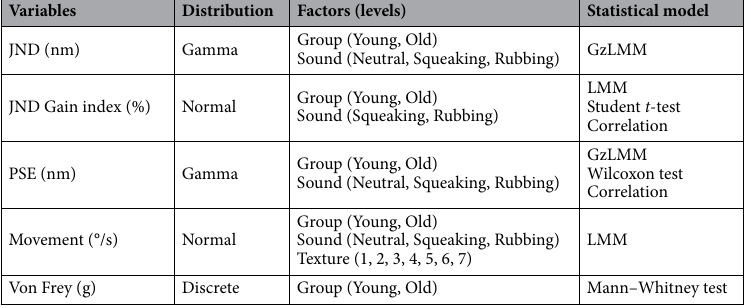
Table 4. Summary of the statistical models used for the analysed